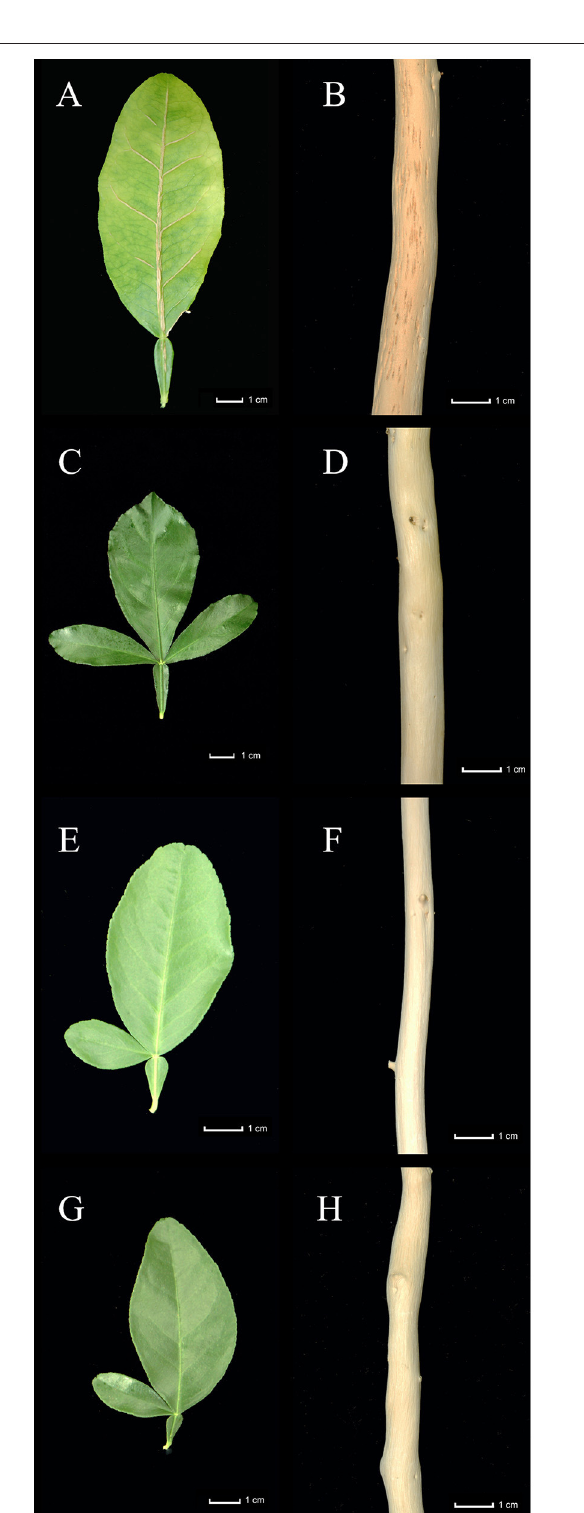
FIGURE 8 | Symptoms on plants inoculated with the T388 strain of Citrus tristeza virus : (A) Yellowing and vein corking in leaf of C. macrophylla (CM). (B) Stem pitting in CM. (C,D) Symptomless leaf and stem of Carrizo citrange. (E,F) Symptomless leaf and stem of somatic hybrid SMC-58. (G,H) Symptomless leaf and stem of somatic hybrid SMC-73.